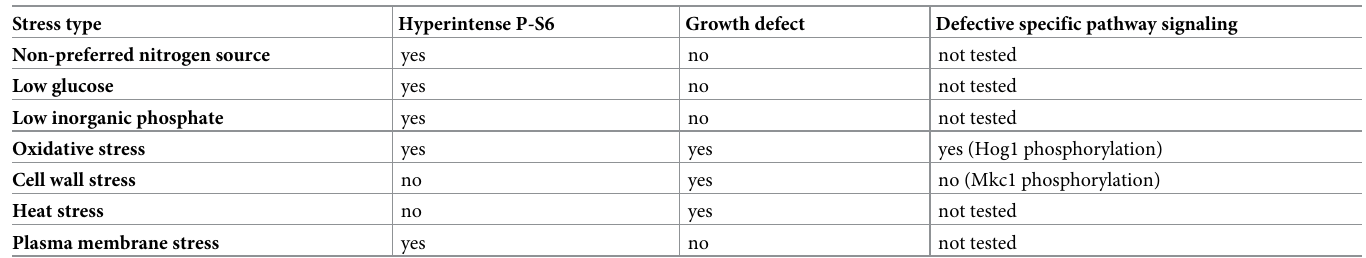
Table 2. Del381 cell responses to specific stress